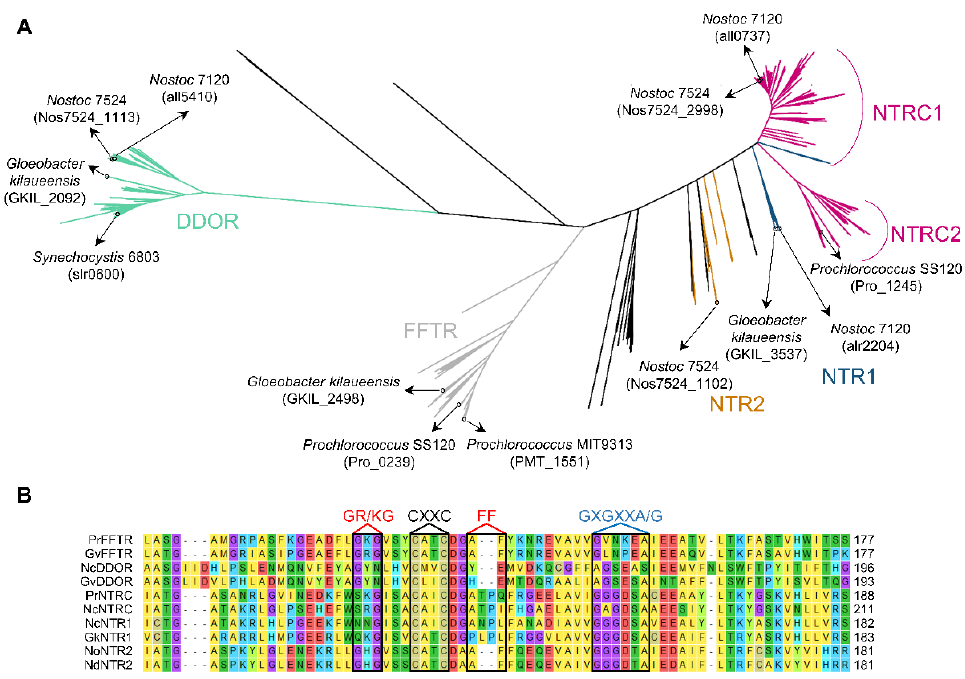
Figure 3. Functional features and evolutionary relationships of TR-related enzymes in cyanobacteria. ( A ) Unrooted tree of amino acid sequences of TR-related enzymes identified in the IMG and NCBI databases. Branches are colored to represent proteins found in the different subclades: DDOR (light blue), FFTR (grey), NTRC (purple), NTR1 (dark blue), and NTR2 (brown). Branches related to E. coli , Melainabacteria, Sericytochromatia, and Margulisbacteria are colored black. ( B ) Multiple protein sequence alignment of several TR-related enzymes. Sequences are indicated with the following abbreviations for organism names: Prochlorococcus marinus SS120 FFTR (PrFFTR), Gloeobacter violaceus FFTR (GvFFTR), Nostoc sp. PCC 7120 DDOR (NcDDOR), Gloeobacter violaceus DDOR (GvDOR), Prochlorococcus marinus SS120 NTRC (PrNTRC), Nostoc sp. PCC 7120 NTRC (NcNTRC), Nostoc sp. PCC 7120 NTR1 (NcNTR1), Gloeobacter kilaueensis NTR1 (GkNTR1), Nostoc sp. PCC 7524 NTR2 (NoNTR2), and Nodularia spumigena CCY9414 (NdNTR2). The motifs for Trx-binding (GR/KG and FF) and NAD(P)H-binding (GXGXXA/G) are shown with boxes in red and blue letters, respectively. Black letters indicate the redox-active Cys (CxxC). The full sequences of each TR-related enzyme are available in Figure